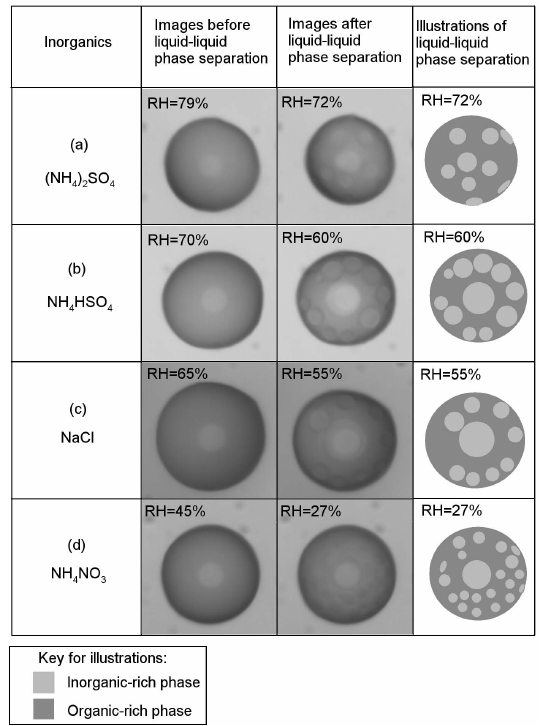
Fig. 1. Optical images and illustrations of particles containing 2- methylglutaric acid and one of the inorganic salts with OIR = 2.0 ± 0.1. Shown in the images and illustrations are the relative humidi- ties at which the images were recorded. The inorganic salts studied were ammonium sulfate in row (a) , ammonium bisulfate in row (b) , sodium cholride in row (c) , and ammonium nitrate in row (d) . The diameter of the particles shown ranged from 28 to